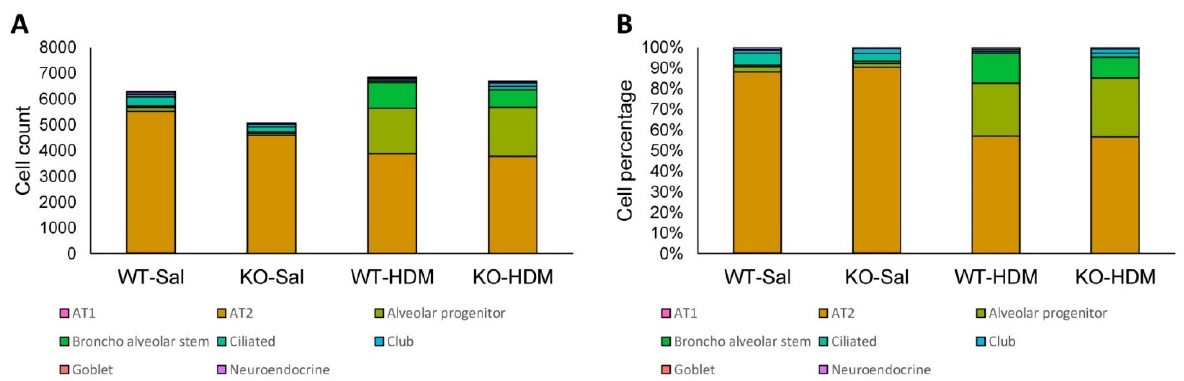
Figure 2. The abundance and percentage of each cell type. ( A ) Abundance of each cell type at each condition; ( B ) percentage of each cell type at each condition.